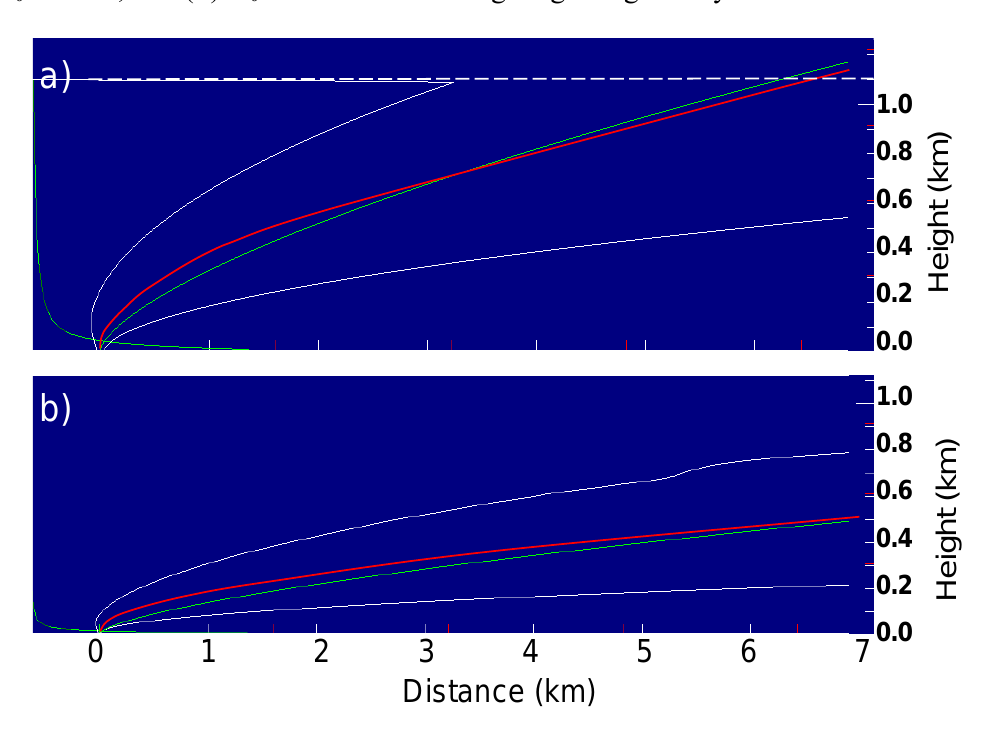
Figure 6. Daysmoke-simulated plume boundaries (white lines), Daysmoke plume centerline (red lines), and Briggs-calculated mean plume trajectories (green lines) for ( a ) D = 62 m; and ( b ) D = 17 m. The mixing height is given by the dashed 0 0